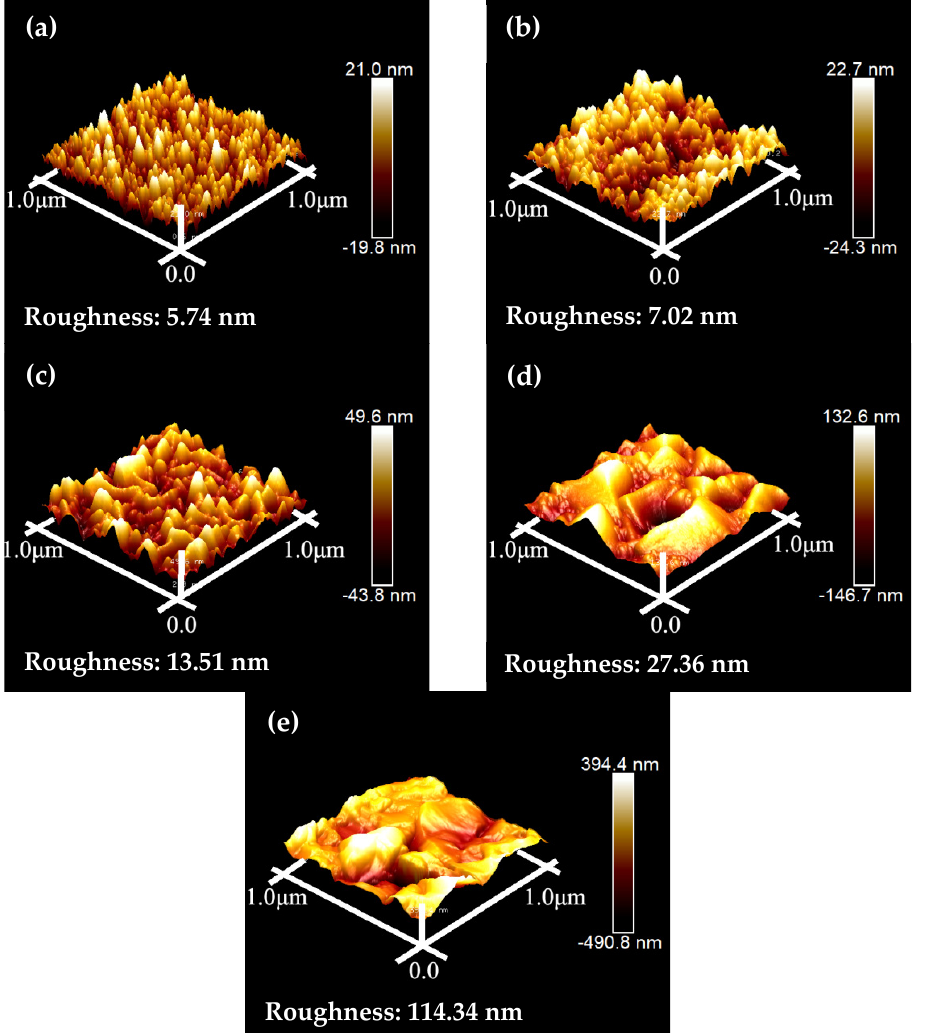
Figure 8. AFM images of samples after annealing at different temperatures: ( a ) 350 °C; ( b ) 400 °C; ( c ) 450 °C; ( d ) 500 °C; ( e ) 550 °C.